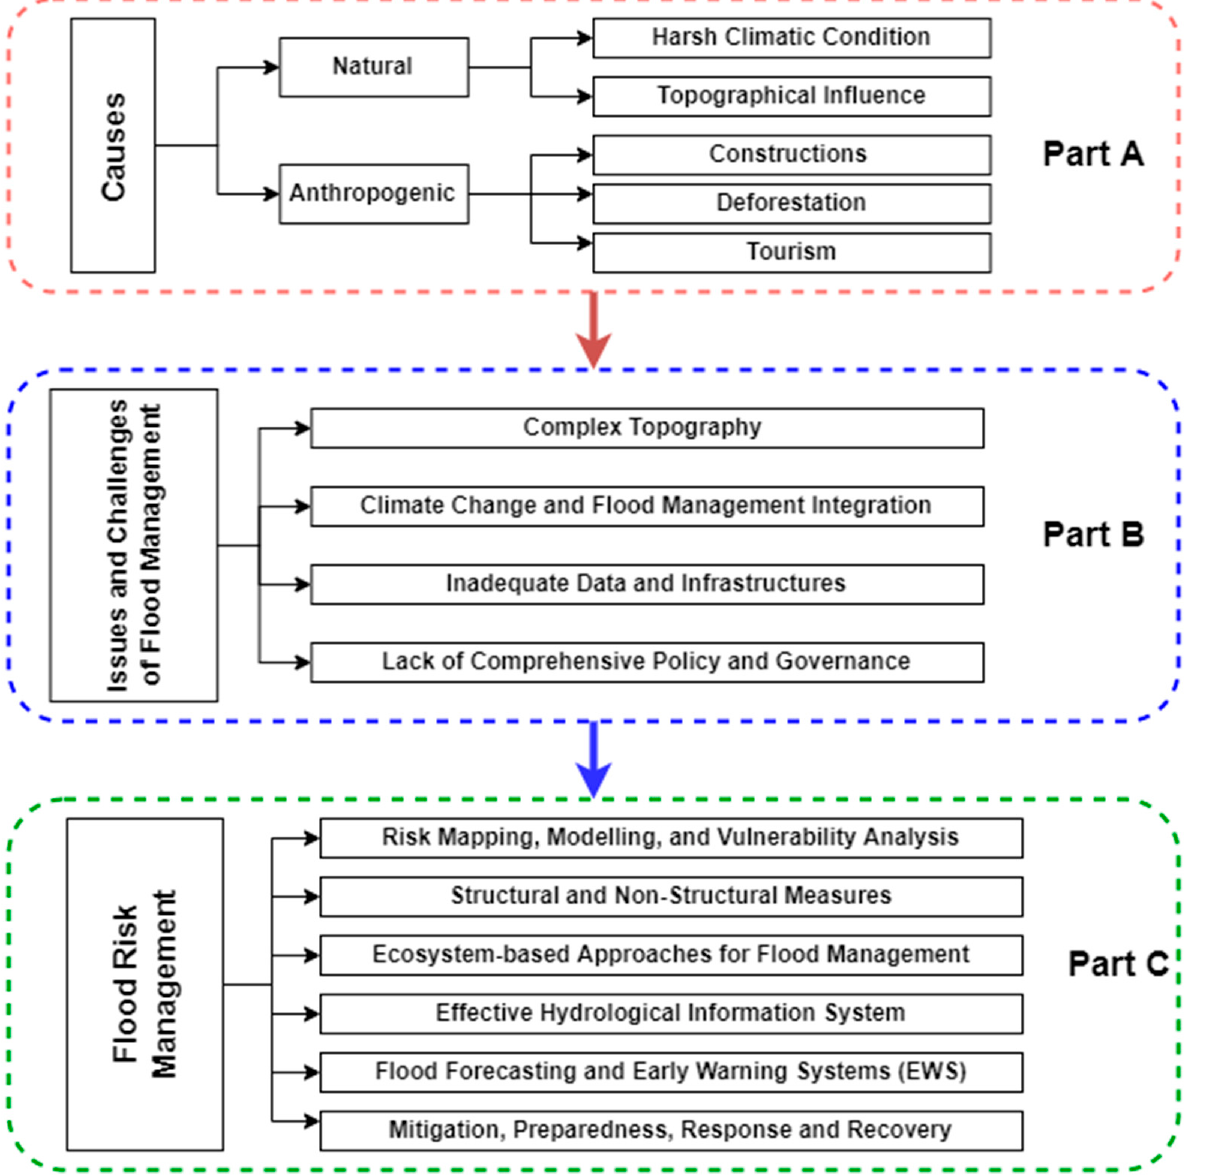
Figure 4. The proposed methodology for flood risk management.